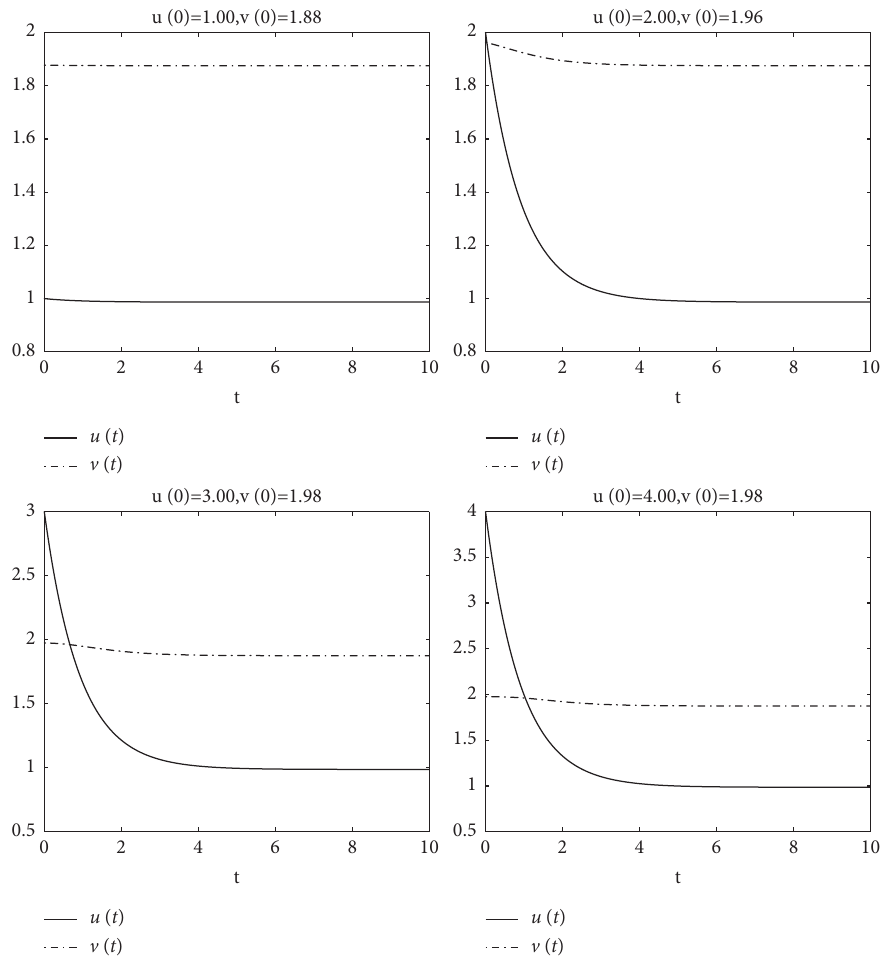
Figure 4: States u ( t ) and v ( t ) of model (62) with different consistent initial values